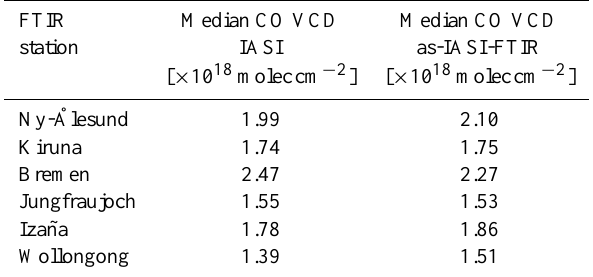
Table 3. Median CO vertical column densities (VCD) for IASI and the as-IASI-FTIR data. FTIR Median CO VCD Median CO VCD station IASI